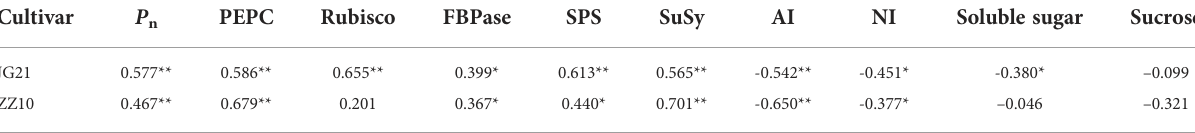
* and ** indicate signi fi cant difference at 0.05 and 0.01 probability levels, respectively. P n , net photosynthetic rate; JG21, Jingu 21; ZZ10, Zhangza 10; PEPC, phosphoenolpyruvate carboxylase; Rubisco, ribulose-1,5-bisphosphate carboxylase-oxygenase; FBPase, Fructose-1,6-bisphosphatase; SPS, sucrose phosphate synthase; SuSy, starch synthase; AI, acid invertase; NI, neutral